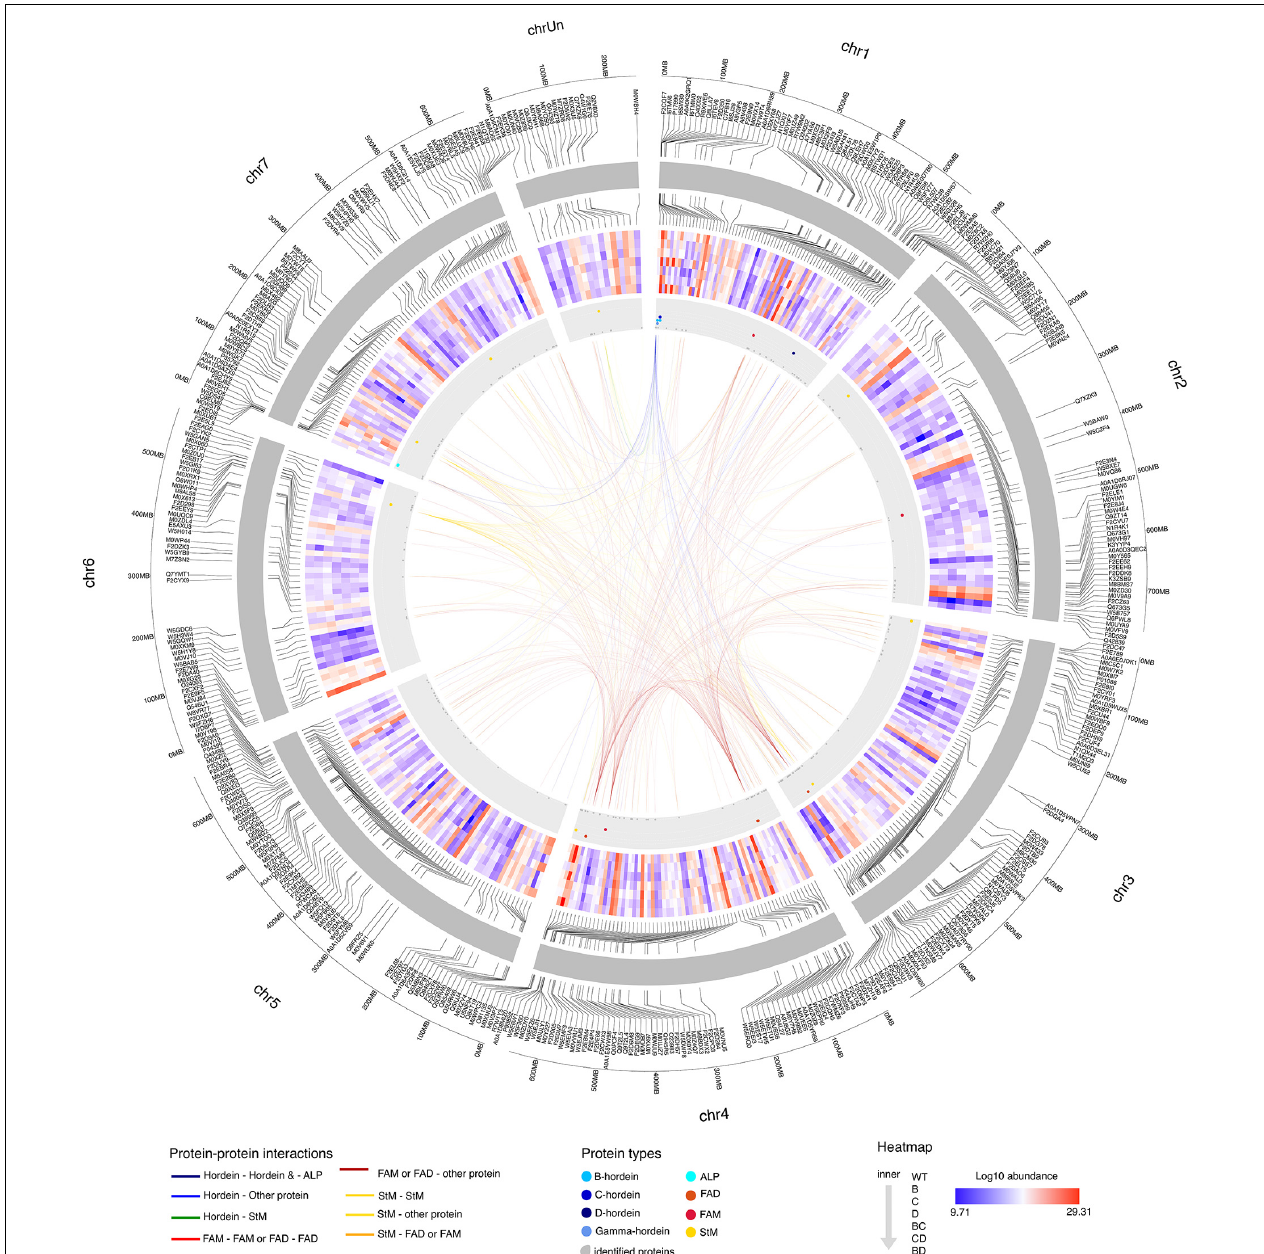
FIGURE 6 | Protein-protein interaction patterns of highlighted hordeins, fatty acid metabolism and degradation and starch metabolism associated proteins. Chromosomes are visualised in the outer circle as grey bands. Mapped proteins showing significant fold-changes compared to the WT are labelled with accession numbers. Log2 protein abundance values are presented in the heat map section. The direction of samples indicated from the inner to the outer circle as WT, single mutants B-, C-, and D-, double-mutants BC-, CD-, and BD-, respectively. The position of hordeins and the highly related avenin-like proteins are shown as blue dots in the grey annotation band, fatty acid metabolism and fatty acid degradation associated proteins are highlighted in red and deep red colours, while orange dots represent proteins related to starch metabolism. Links between chromosome regions represent potential interactions. Only correlations above 0.95 (strong positive) and below -0.95 (strong negative) are highlighted. Interactions are coloured to indicate the interactor